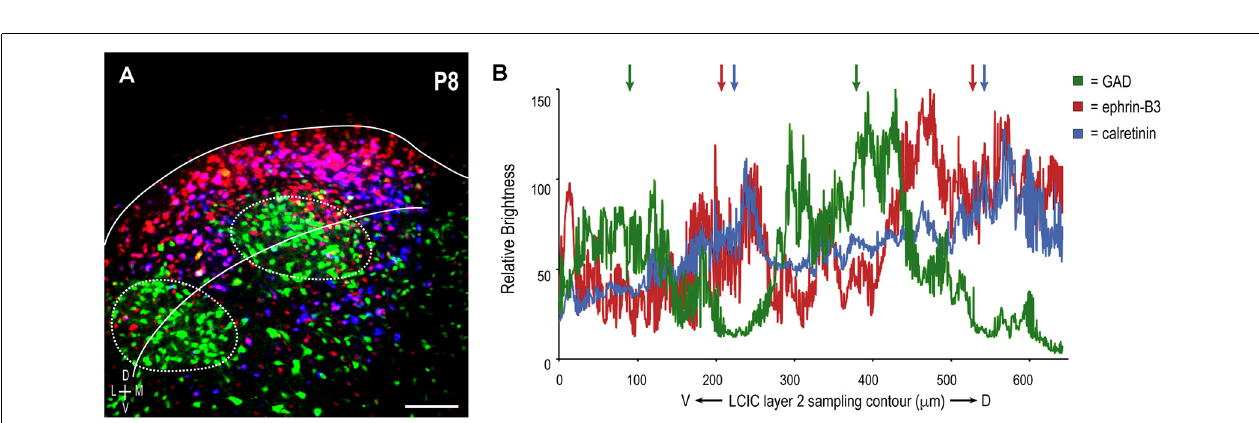
FIGURE 4 | LCIC sampling and corresponding brightness profiles of extracted GAD (green), ephrin-B3 (red), and calretinin (blue) channels in a representative P8 mouse. Consistent ROI sampling curved contour in panel (A) bisecting LCIC layer 2 modular fields facilitates comparisons of relative signal fluctuations for each label (B) . Each exhibits a periodic component, in keeping with discontinuous compartments along the ventrolateral-to-dorsomedial extent of the LCIC. Ephrin-B3 and calretinin waveforms are largely in-phase with each other (red and blue arrows, respectively), and out-of-phase with that of GAD oscillations (green arrows). Such reliable alignment (with CR) and offset (with GAD) suggests a high degree of ephrin-B3 expression specificity that corresponds with the emerging LCIC extramodular matrix. Scale bar in (A) = 100 µ